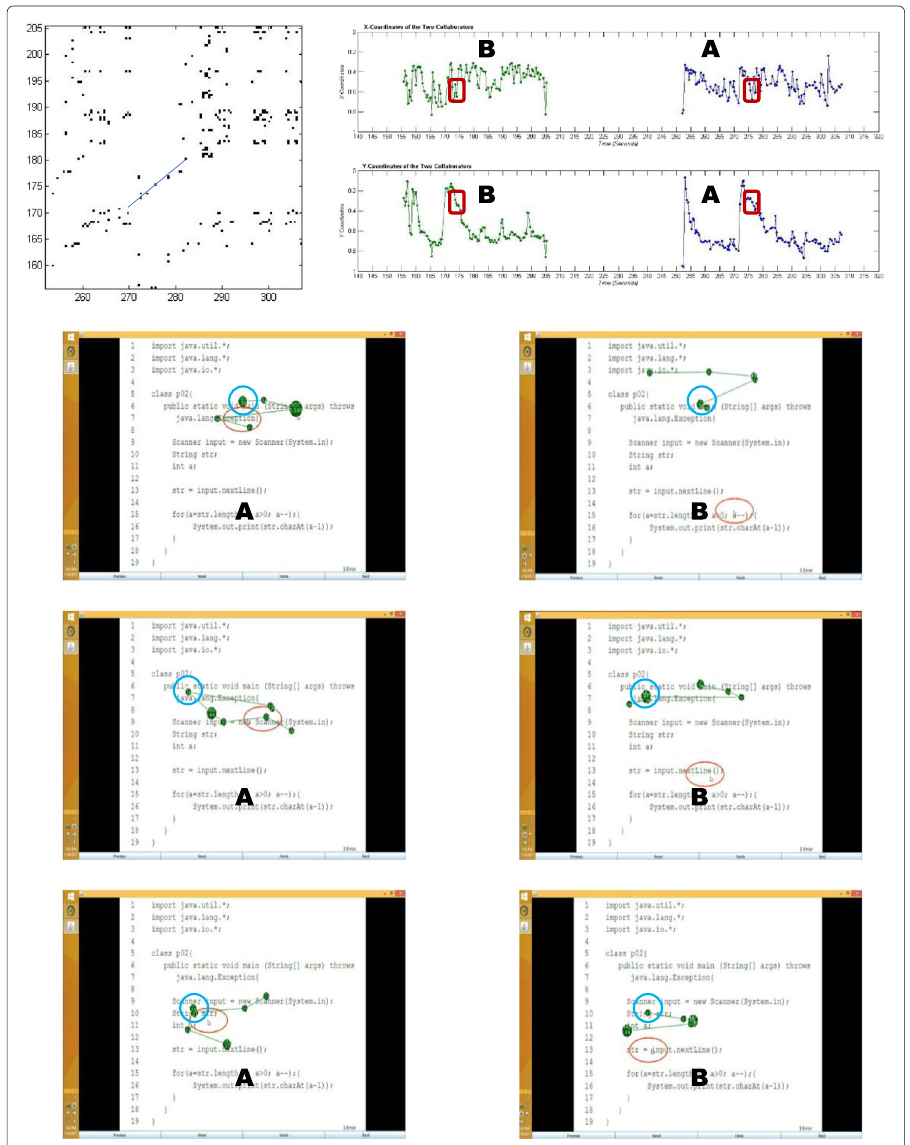
Fig. 6 An example of frequent but short